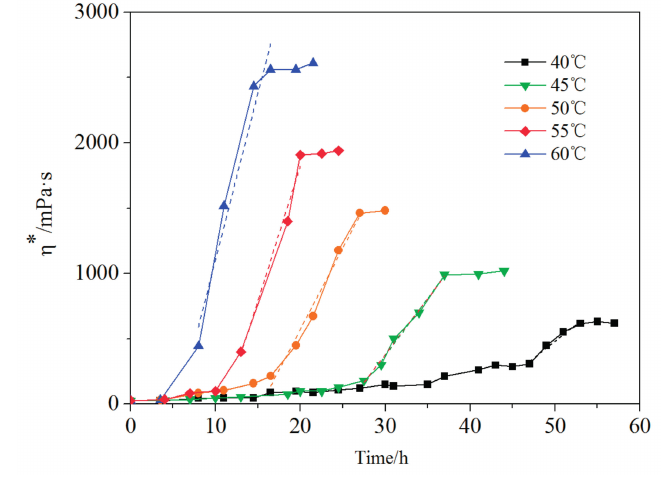
Figure 12. Effect of temperature on the crosslinking reaction process of the polymer